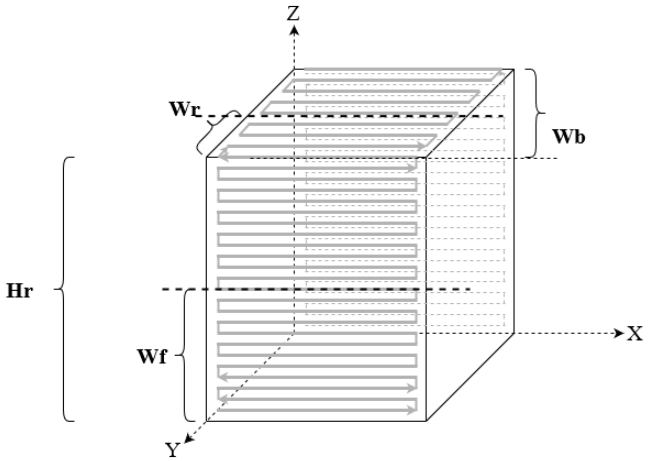
Figure 4. Divided trajectory in several parts when the drone resources are not enough to cover the whole building in one